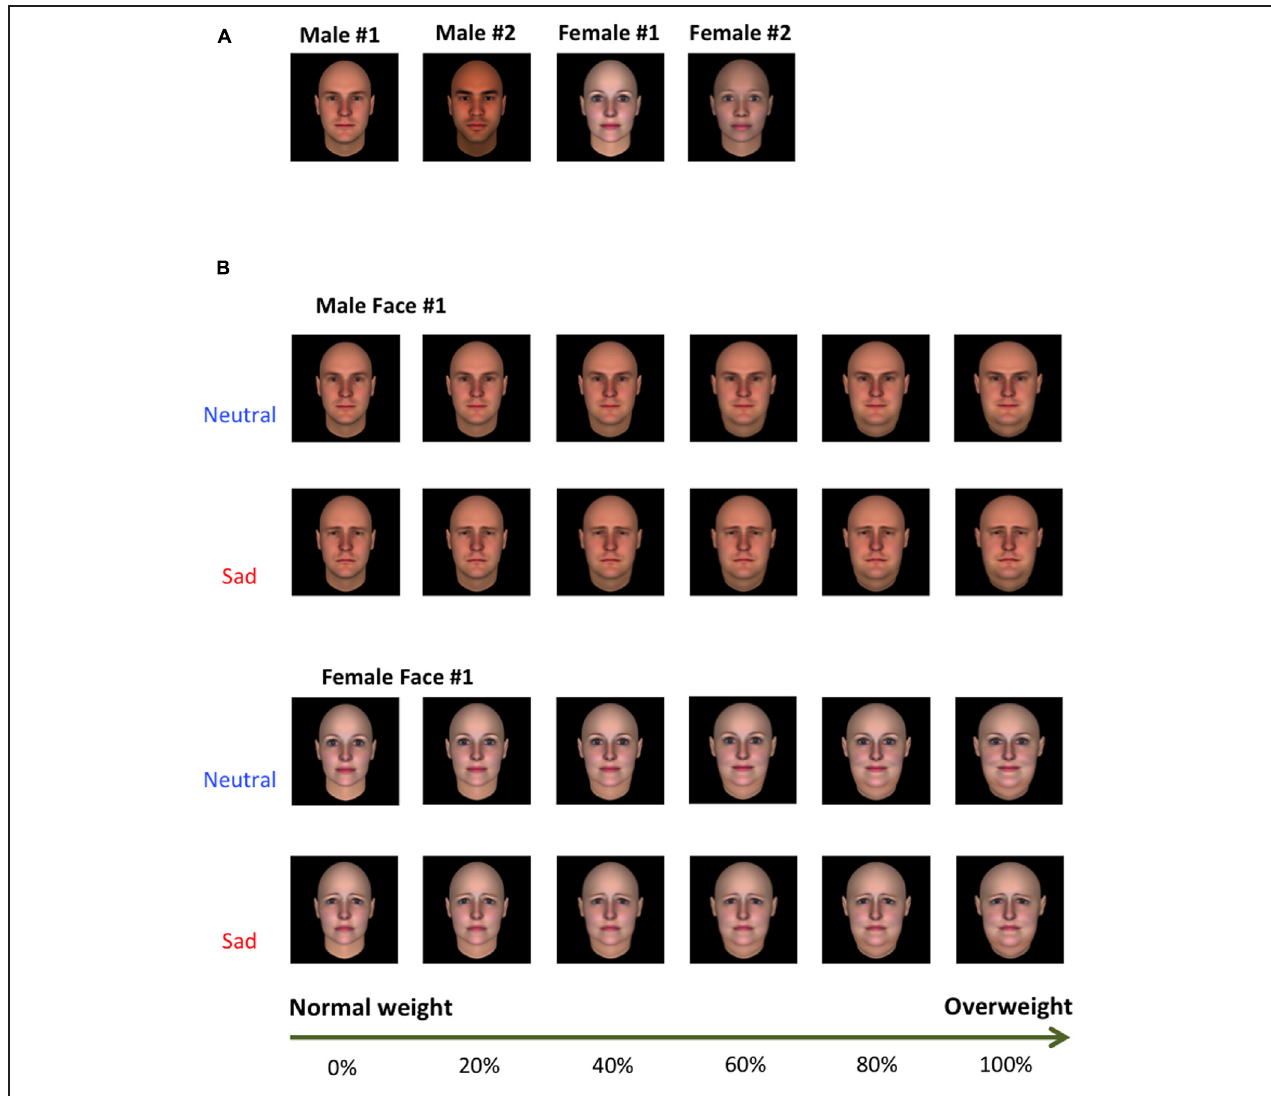
FIGURE 1 | (A) Exemplar facial stimuli used for the weight judgment task. A total of four identities (two male identities and two female identities) were used in the main experiment. Normal weight (0%) images are shown. (B) Emotional expression and weight of facial stimuli were